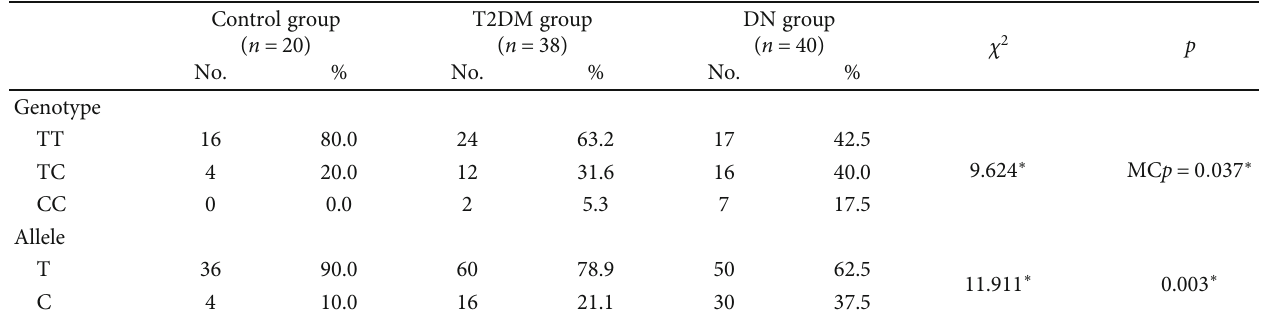
Table 3: Comparison between the studied groups according to genotype distribution.